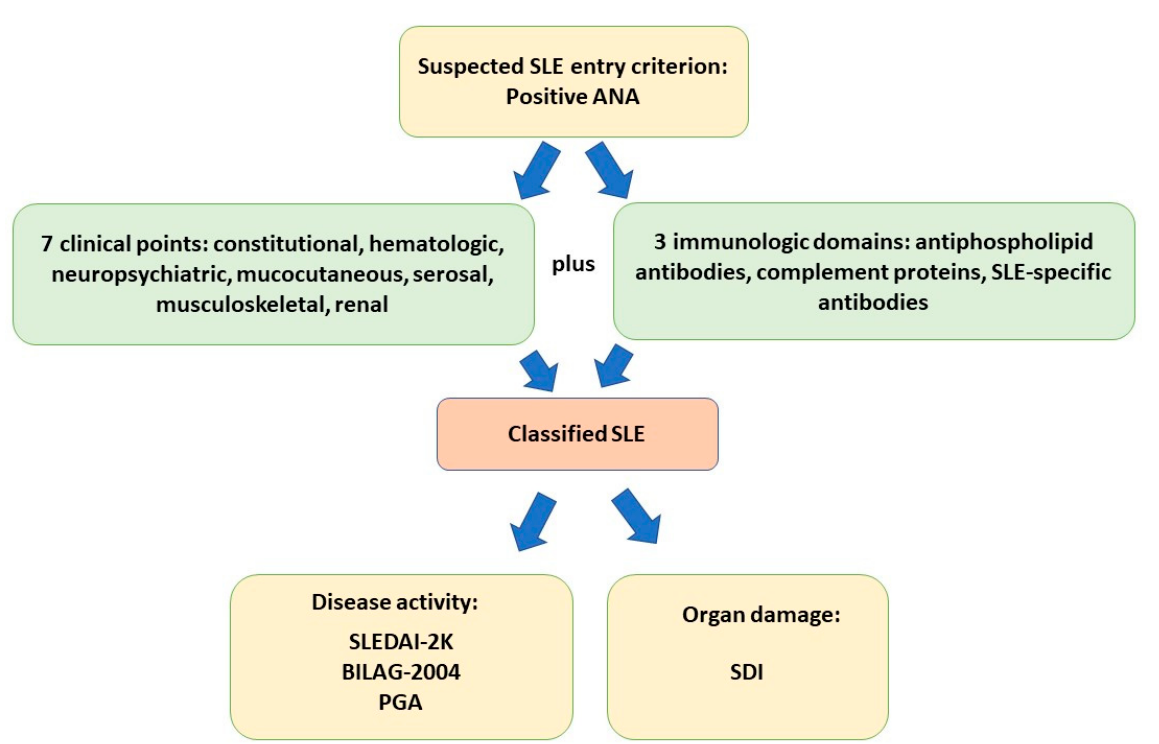
Figure 1. SLE classification according to EULAR/ACR 2019 criteria and measurement of disease activity and organ damage. The entry criterion consists of antinuclear antibody (ANA) positivity on at least one occasion. Definitive diagnosis requires 10 points derived from clinical and immunologic criteria. Disease activity is assessed by the SLE Disease Activity Index-2000 (SLEDAI-2K), British Isles Lupus Activity Group 2004 (BILAG 2004), and Physician Global Assessment (PGA). Organ damage is assessed by the SLICC/ACR damage index (SDI).